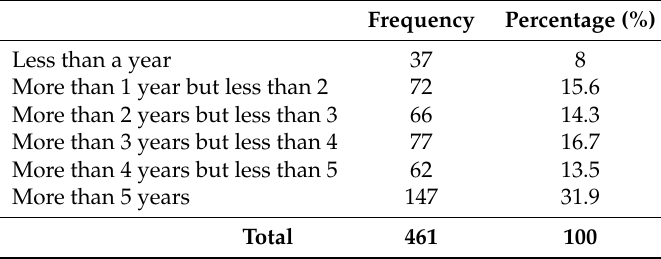
Table 3. How long the respondent has had a